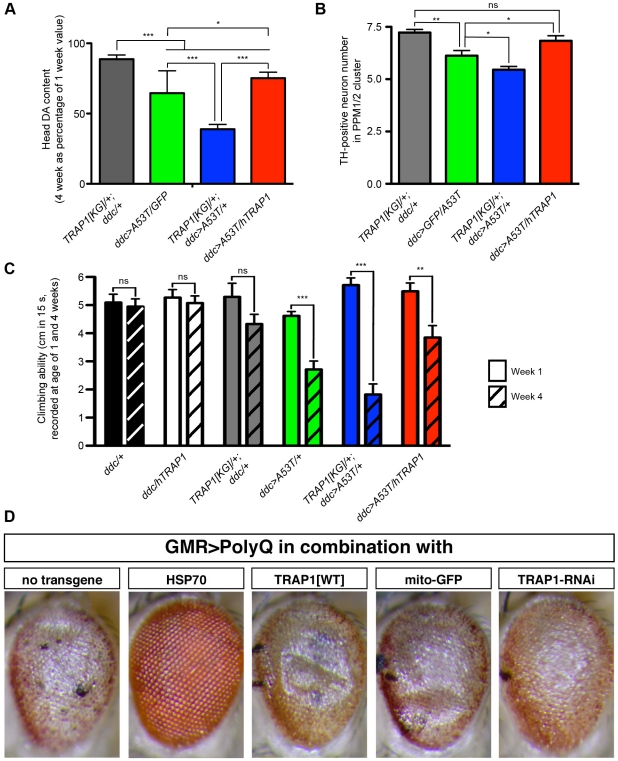
TRAP1 overexpression mitigates detrimental effects induced by neuronal [A53T]α-Synuclein expression.(A) Overexpression of [A53T]α-Synuclein under control of ddc-GAL4 resulted in reduction of DA in fly heads at 4 weeks, which was potentiated by TRAP1 deficiency (TRAP1[KG]/+;ddc>A53T/+), but mitigated by TRAP1 overexpression (ddc>A53T/hTRAP1). (B) ddc>A53T flies display a reduction of TH-positive neurons, which was potentiated by TRAP1 deficiency, but rescued to control levels by TRAP1 overexpression. (C) In negative geotaxis assays ddc>A53T flies displayed a time-dependent decline in locomotion. Reduction of TRAP1 enhanced the inability to climb (although not significant), while overexpression of hTRAP1 provided a significant rescue effect (comparison of ddc>A53T/+ vs ddc>A53T/hTRAP1 at 4 weeks: p<0.05). Statistics in (A, B): ANOVA followed by Newman-Keuls Multiple Comparison Test; (C): 2-way ANOVA followed by Bonferroni post-hoc tests. Displayed are biologically relevant comparisons. *p<0.05; **p<0.01; ***p<0.001; ns = not significant. (D) Alterations in TRAP1 levels did not influence PolyQ-induced rough eye phenotypes. Light micrographs of external eye structures show that PolyQ-induced REP was suppressed by parallel expression of HSP70. In contrast, neither overexpression of hTRAP1 or silencing of endogenous TRAP1 by RNAi had an obvious impact on external eye structure. Expression of mitochondrial localized GFP (mito-GFP) served as control.